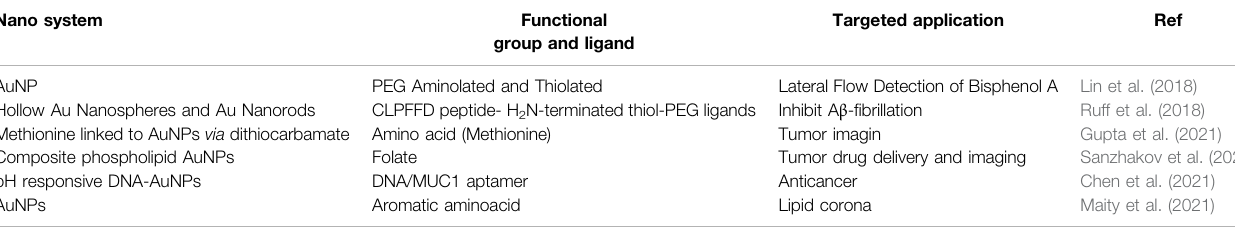
TABLE 2 | Functionalization of